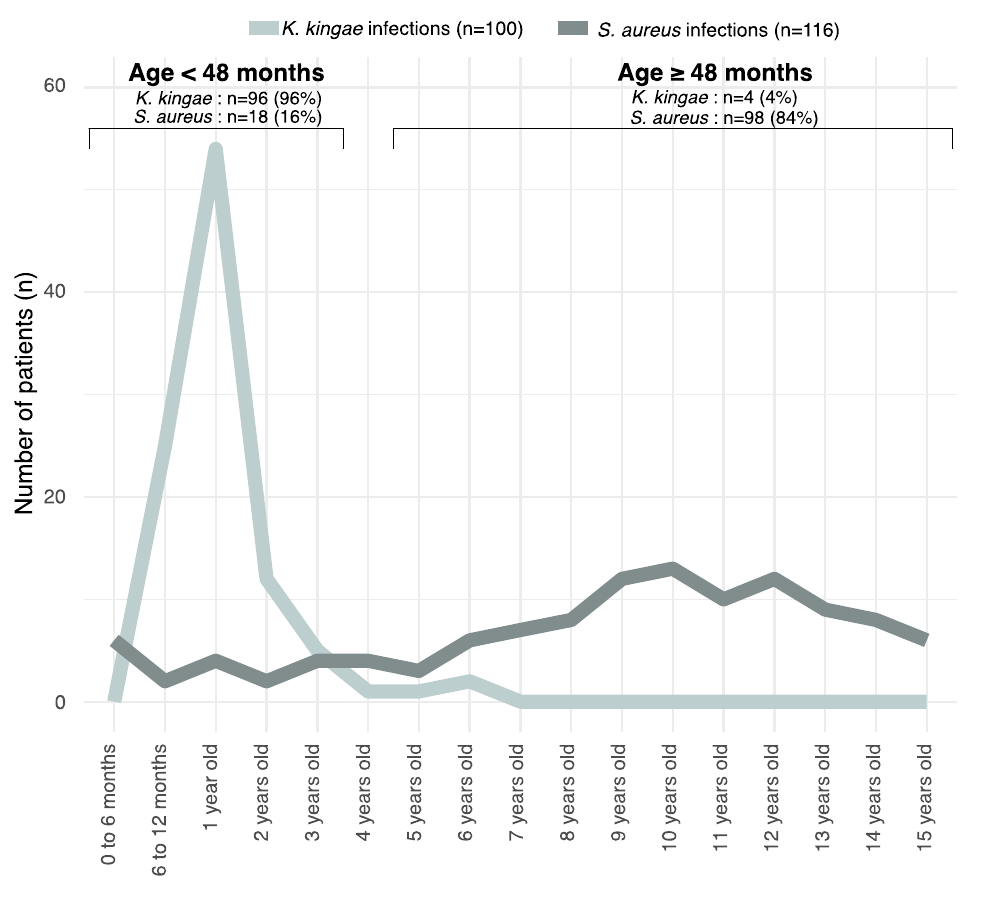
Figure 1. Age at infection for K. kingae and S. aureus . This chart shows that the incidence of K. kingae OAI is greater before 4 years old and almost disappears in older